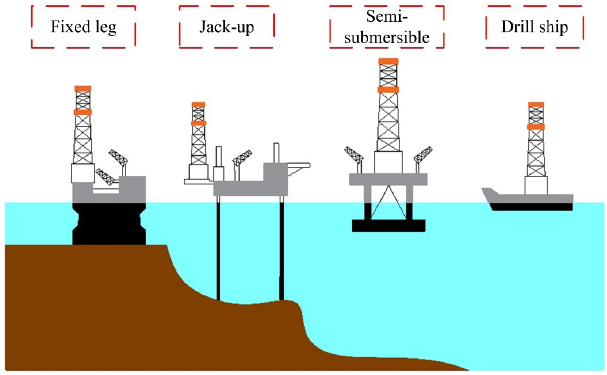
Figure 12. Different platforms for offshore drilling [10].